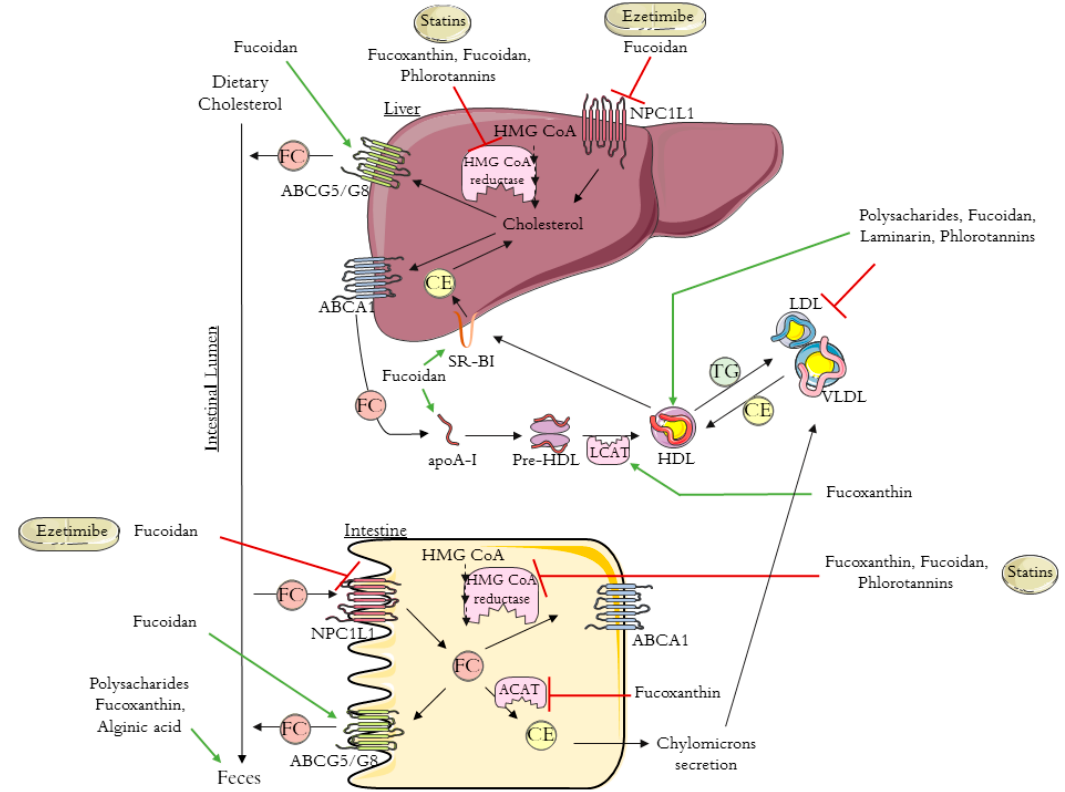
Figure 1. Schematic diagram of reverse cholesterol transport (RCT), intestinal cholesterol absorption, and the mechanisms of action of ezetimibe, statins, and brown algae compounds on cholesterol metabolism (polysaccharides, fucoxanthin, fucoidan, alginic acid, laminarin, and phlorotannins). HMG-CoA: 3-hydroxy-3-methyl-glutaryl coenzyme A; NPC1L1: